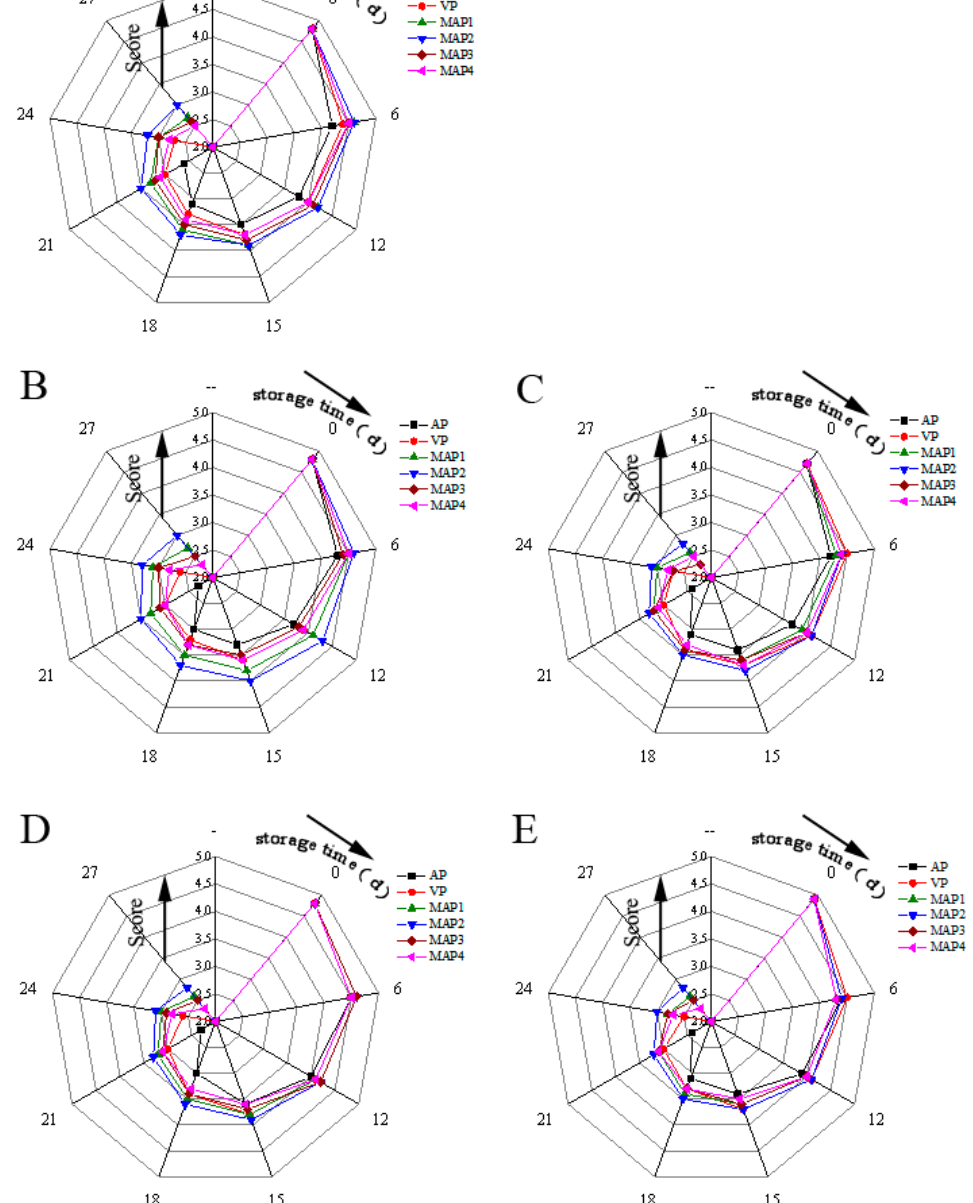
Figure 5. Organoleptic evaluation results of odor ( A ), color ( B ), mucus ( C ), elasticity ( D ) and tissue morphology ( E ) of turbot under different treatments during storage period(AP: air packing; VP: vacuum packing; MAP1: 70% CO 2 /30% N 2 ; MAP2: 60% CO 2 /10% O 2 /30% N 2 ; MAP3: 50% CO 2 /15% O 2 /35% N 2 ; MAP4: 55% CO 2 /5% O 2 /40% N 2 ).